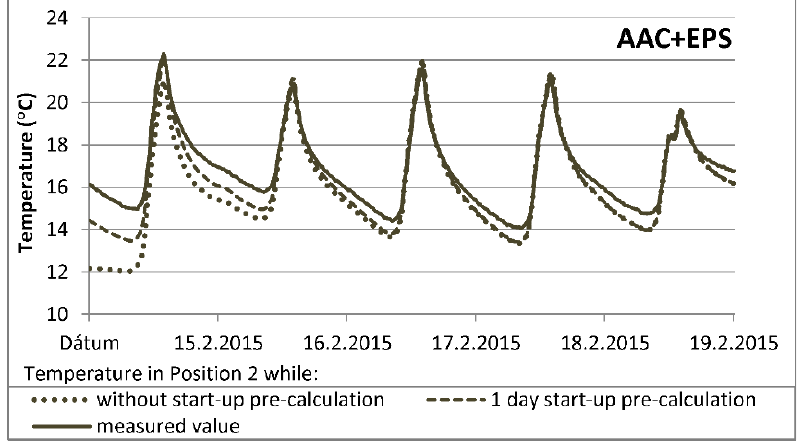
Figure 16. Plotted calculated and measured temperature courses in the outdoor test cell wall S1 in Position 2 during the chosen time period — with and without pre-calculation considerations.